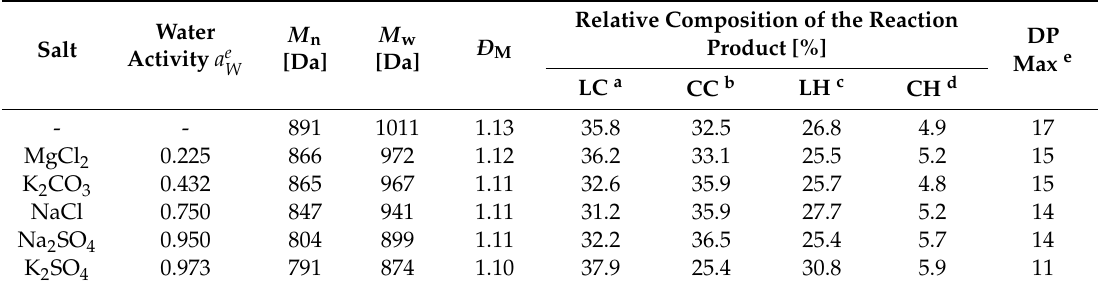
Table 2. Influence of the initial water activity on the molecular weight and composition of the copolymerization products of ε -Caprolactone (ECL) and 5-hydroxymethyl furanoic acid